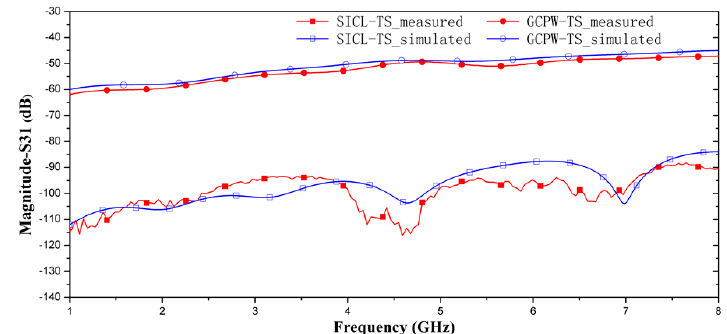
Figure 6. Comparison between simulated and measured |S (cid:2870)(cid:2869) | of the SICL-TS and the GCPW-TS.